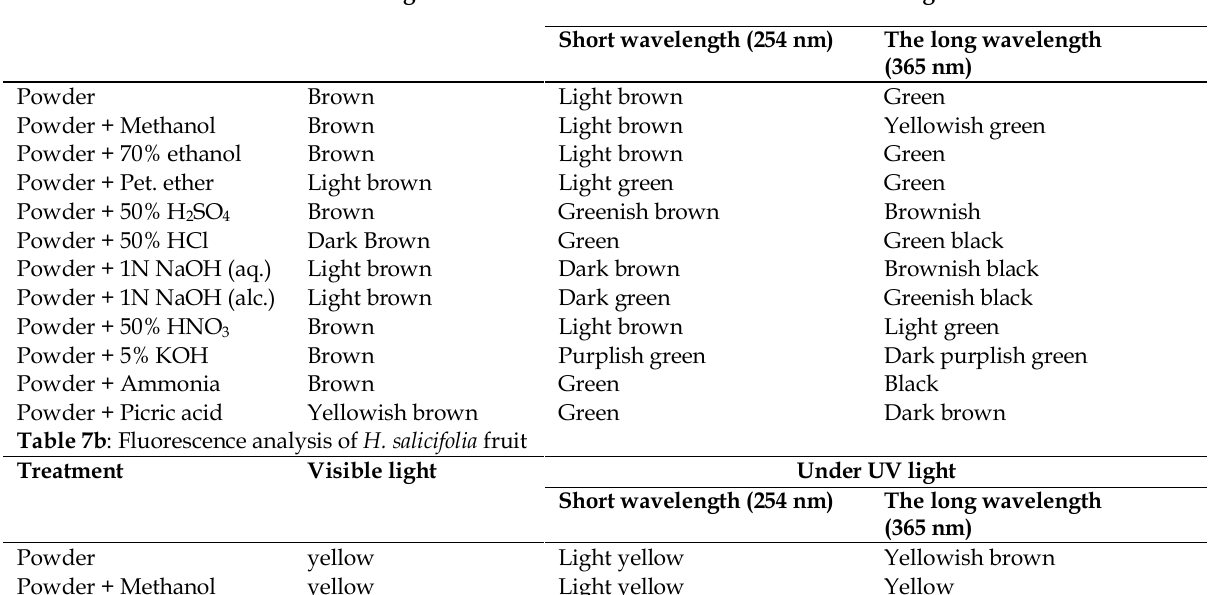
Table 7b : Fluorescence analysis of H. salicifolia fruit Treatment